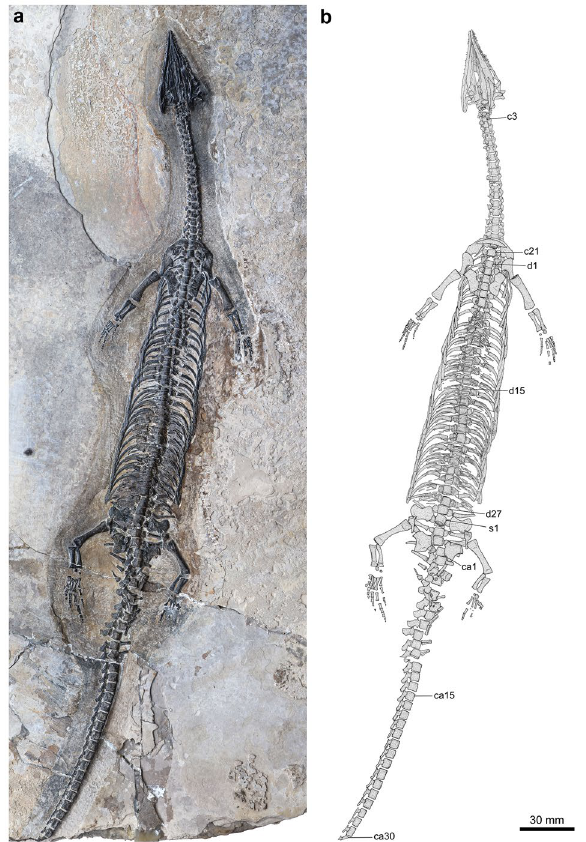
Figure 2. Luopingosaurus imparilis gen. et sp. nov., Holotype (IVPP V19049). Photo ( a ) and line-drawing ( b ) of whole specimen. c, cervical vertebra; ca, caudal vertebra; d, dorsal vertebra; s, sacral